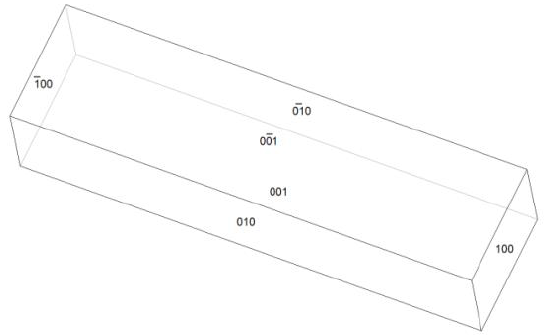
Figure 2. Typical prismatic shape of crystals of the RE(OAc) 3 · 2AcOH structure type. Single crystals suitable for X-ray measurements were selected under a microscope and mounted on a 50 µ m MicroMesh MiTeGen Micromount TM using FROMBLIN Y perfluo- ropolyether (LVAC 16/6, Aldrich) before they were centered on a Bruker Kappa APEX II CCD-based 4-circle X-ray diffractometer using graphite monochromated Mo K α radiation ( λ = 0.71073 Å) of a fine focus molybdenum-target X-ray tube operating at 50 kV and 30 mA. The crystal-to-detector distance was 40 mm and exposure time was 5 s per frame for all samples with a scan width of 0.5 ◦ . Samples were cooled down to 100 K by use of a Kryoflex low temperature